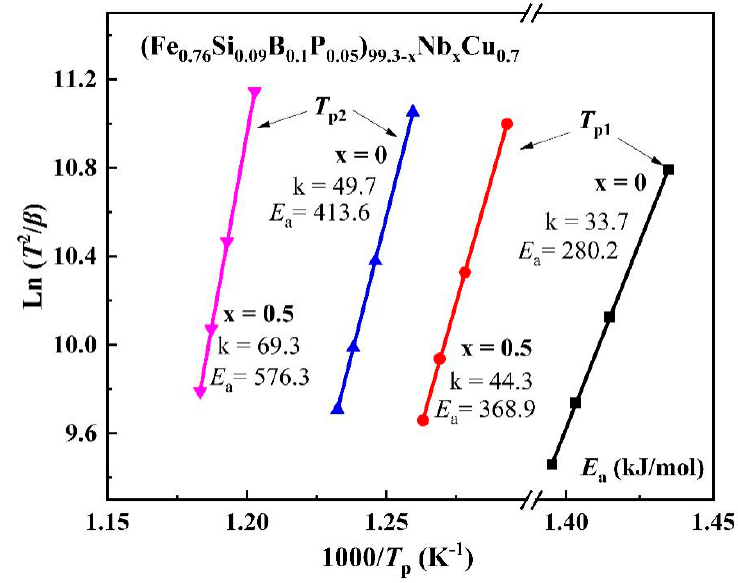
Figure 3. Kissinger plots for the (Fe 0.76 Si 0.09 B 0.1 P 0.05 ) 99.3 − x Nb x Cu 0.7 ( x = 0 and 0.5) ribbons.